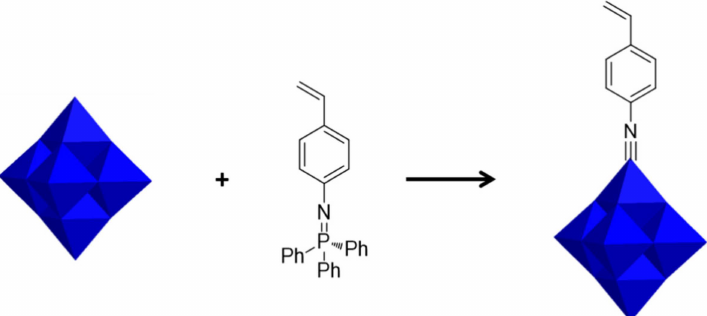
Figure 5. Preparation of POM-based monomer by imidization. Reprinted with permission from [58]. Copyright (2019)